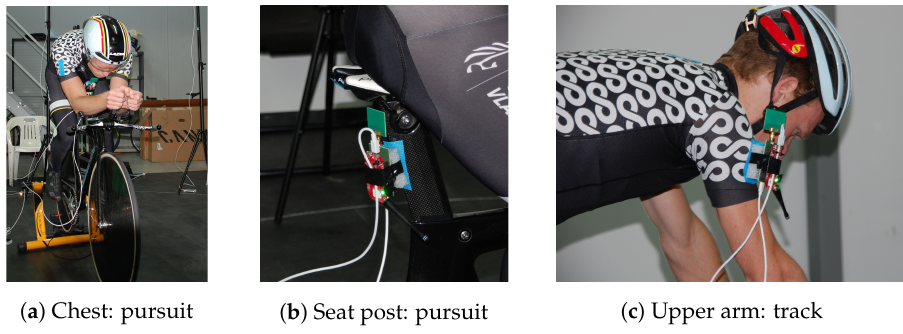
Figure 9. Different tag positions on different